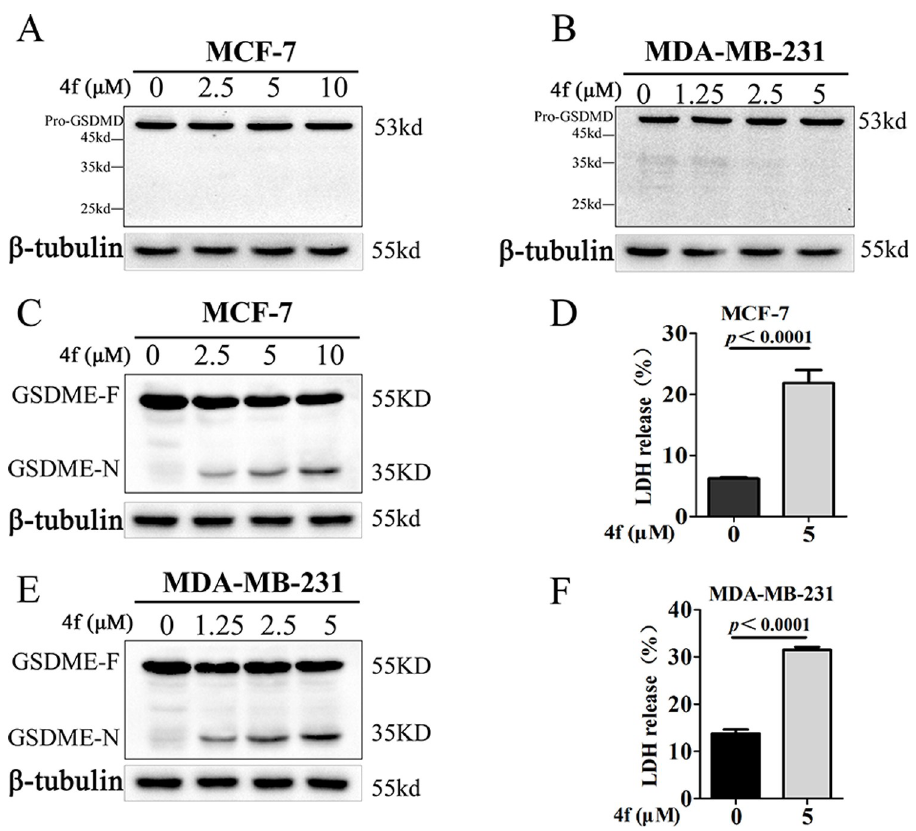
Fig 7. GSDME rather than GSDMD is cleaved during cell pyroptosis of breast cancer cells induced by 4f. (A, B) Full-length GSDMD (GSDMD-F) and GSDMD-C terminal (GSDMD-C) were detected by western blotting in MCF-7 and MDA-MB-231 cells treated with different doses of 4f . (C, E) Full-length GSDME (GSDME-F) and GSDME-N terminal (GSDME-N) were analyzed by western blotting in MCF-7 and MDA-MB-231 cells treated with different doses of 4f . (D, F) LDH release of MCF-7 and MDA-MB-231 cells treated with 4f at the concentration of 0 or 5 μ M. All the data repeated for three